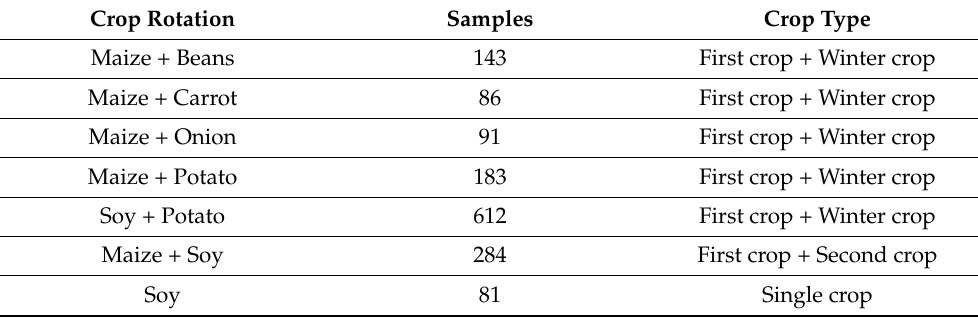
sampled evenly within the pivot. Points were obtained within a buffer 30 m away from the pivot edges. Afterward, EVI time series data were extracted for each sample point. Table 1. Definition of the crop rotation (classes), crop type, and the number of samples for training and validation of the model.